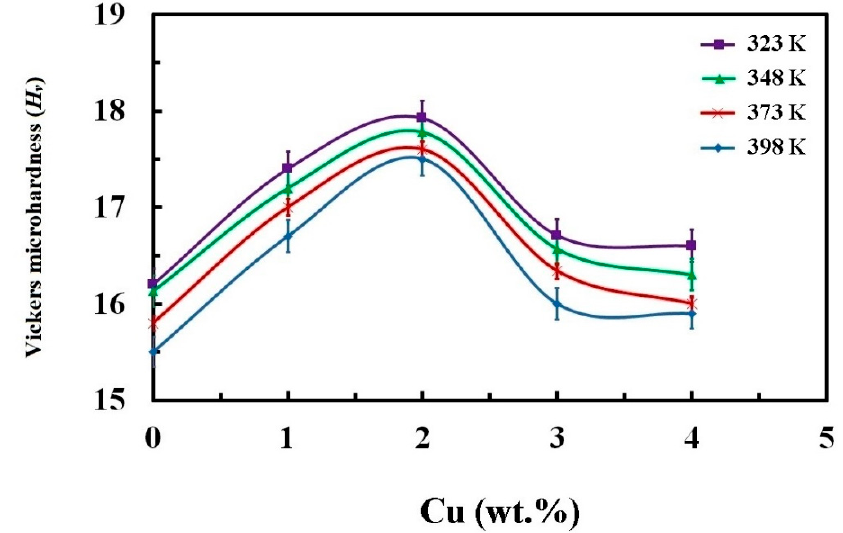
Figure 2. Variation of hardness with Cu content at different aging temperatures.